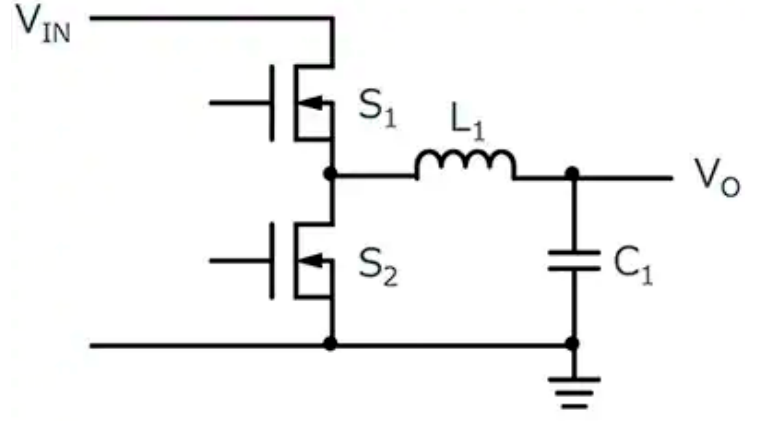
Figure 4. Basic circuit of a buck converter.